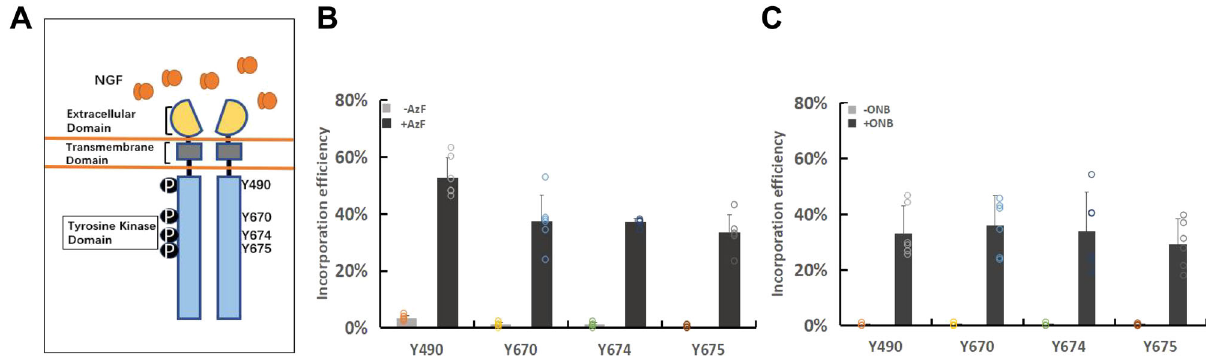
Fig. 3 Expression of TrkA mutants containing AzF or ONB at positions 490, 670, 674, and 675, respectively. a Schematic diagram of the full-length TrkA with ECD, TM and intracellular TrkA domains. Ligand NGF binds at the ECD domain. Four phosphorylated tyrosine sites subjected to mutation are highlighted. b The incorporation ef fi ciency of TrkA AzF mutants in the absence (gray) or presence (dark) of AzF. c The incorporation ef fi ciency expression of TrkA ONB mutants in the absence (gray) or presence (dark) of ONB. The incorporation ef fi ciency was described as the percentage ratio of average fl uorescence intensity in cells expressing Uaa-incorporating receptors divided by the average fl uorescence intensity in cells expressing the WT receptors. n = 6 independent experiments. Error bars show